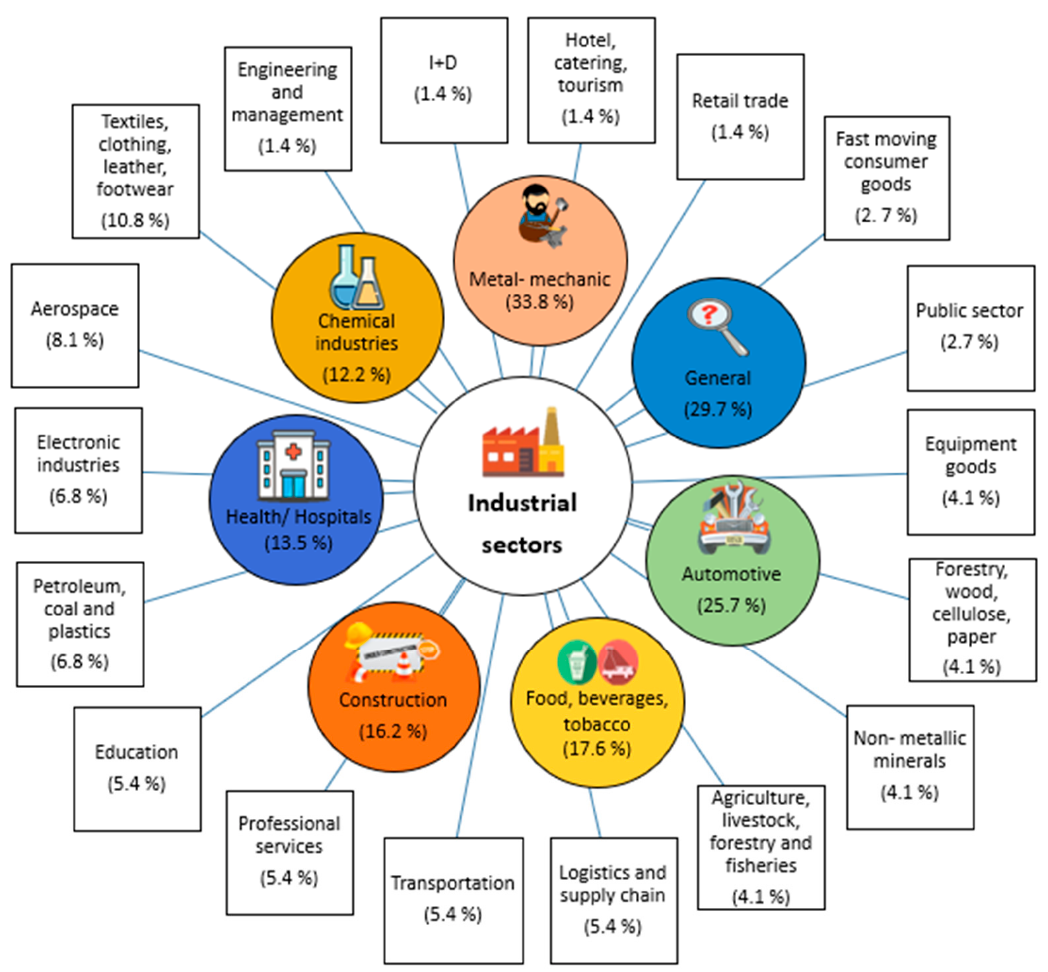
Figure 5. Primary industries identified by the reviewed articles.